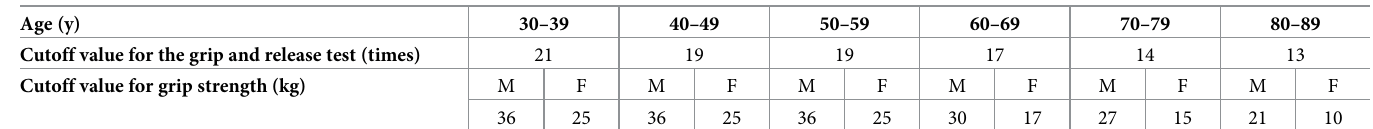
Table 5. Cutoff value for the grip and release test [41] and grip strength